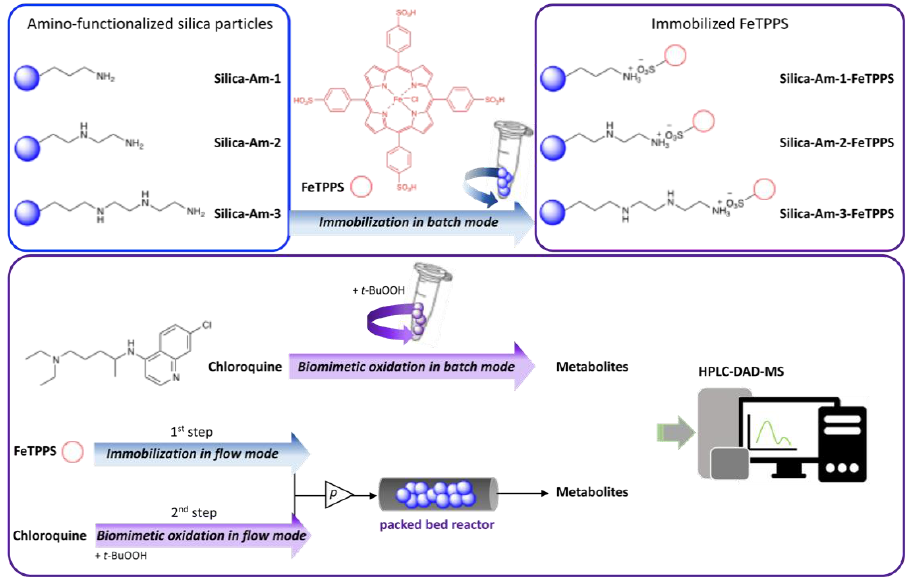
Figure 1. Immobilization of FeTPPS metalloporphyrin on silica particles functionalized with differ- ent amino-linker and application of immobilized FeTPPS for biomimetic oxidation of chloroquine in batch and continuous-flow mode.